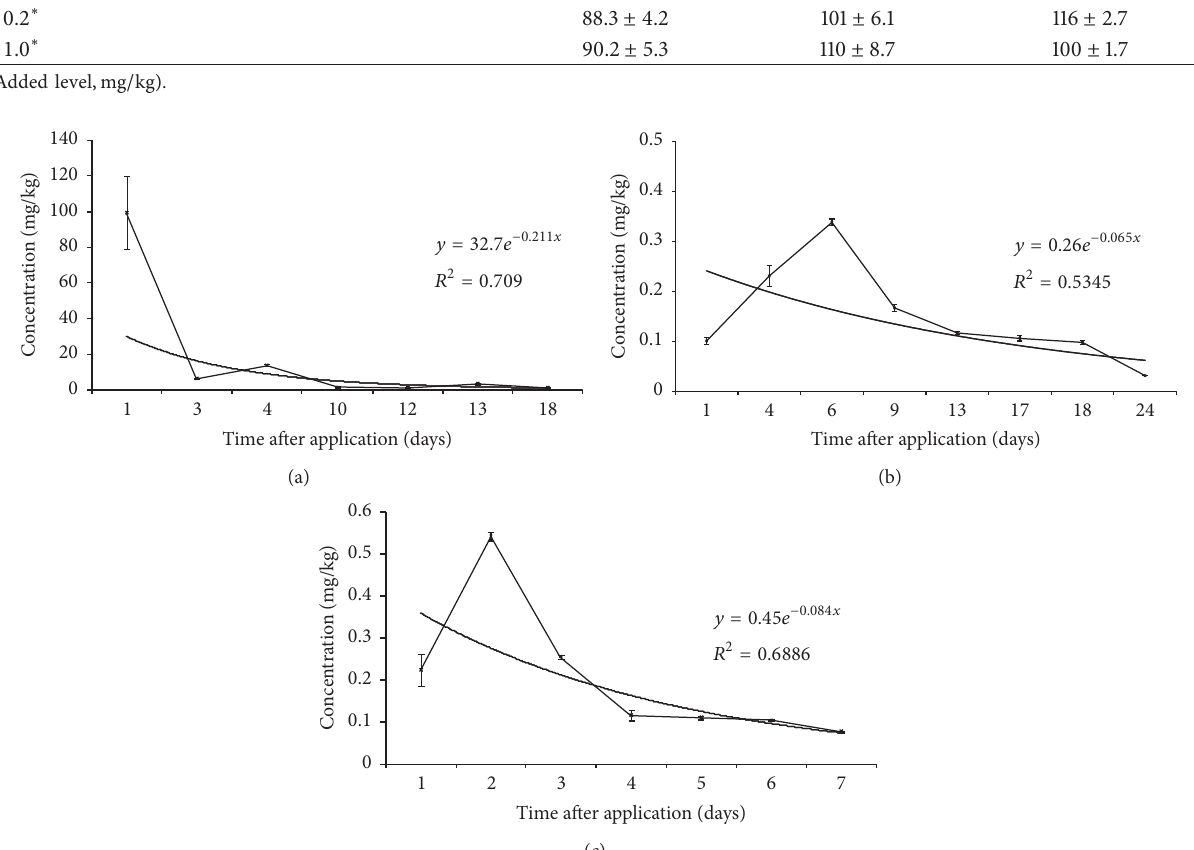
Figure 2: The concentration change of carbendazim in apicultural products established by mathematical analysis for curve fitting (a) pollen; (b) honey; (c)